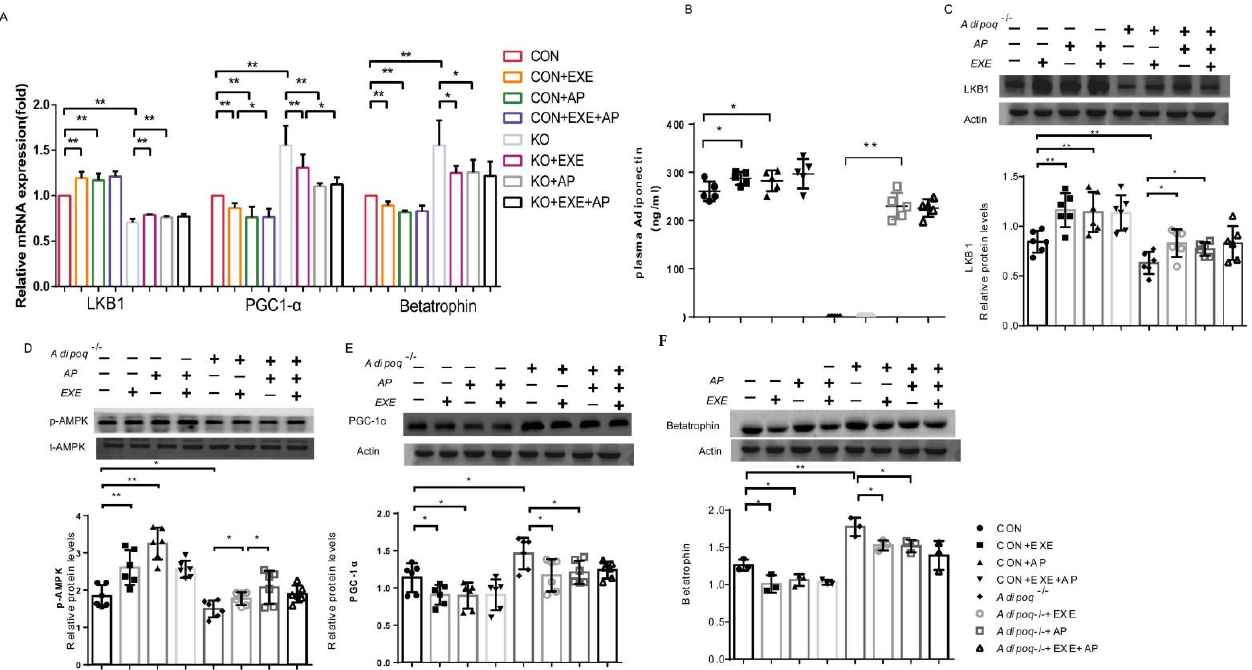
Figure 3. Exercise and adiponectin co-intervention reduces betatrophin expression in mouse liver. ( A ) mRNA levels of Lkb1, Ppargc1a, and Angptl8 were measured using RT-qPCR. All PCRs were performed in at least three independent experiments, in triplicate. ( B ) Plasma concentrations of adiponectin and betatrophin determined using ELISA at the end of the interventions (n = 6–8 in each group). ( C – F ) Western blot analysis of LKB1, p-AMPK, PGC-1 α , and betatrophin expression (Wild type [CON] and Adipoq-/- mice received an i.p. injection of either Acrp30 [28 µg kg − 1 day − 1 ] or saline